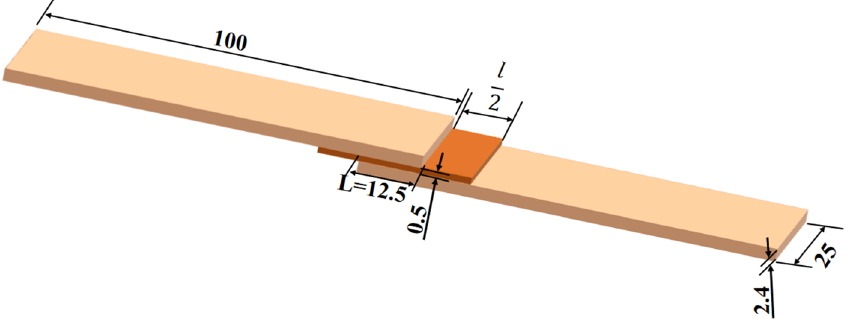
Figure 12. Schematic diagram of different adhesive layer overflow length.